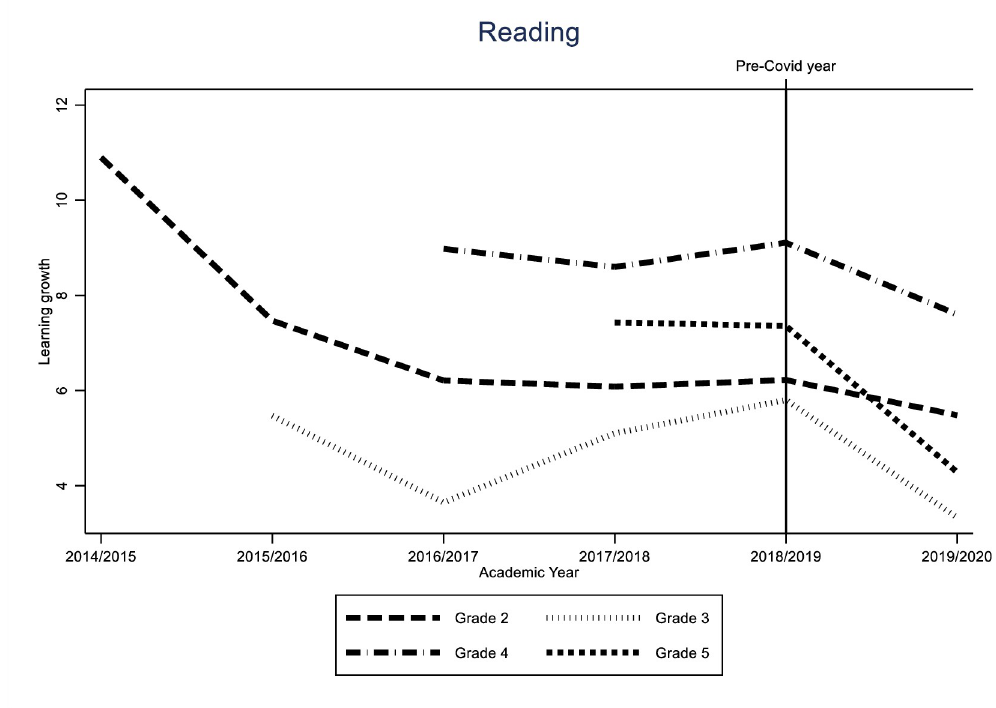
Fig 5. Trends in learning gain over